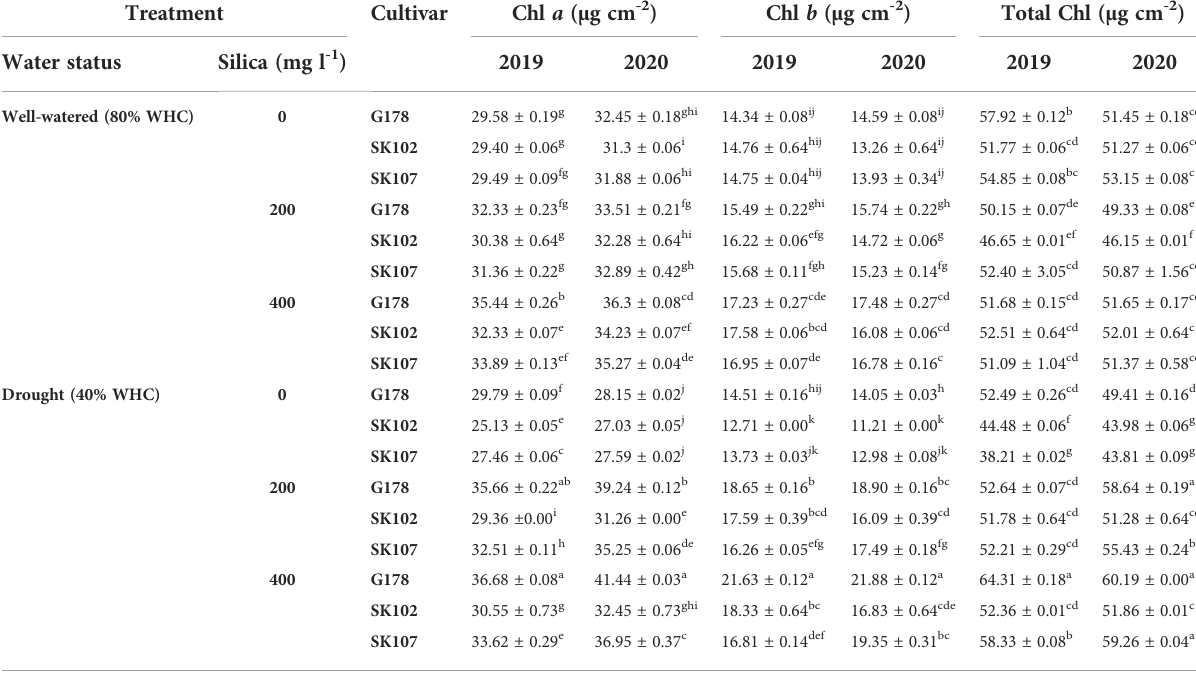
TABLE 5 Effects of foliar application of silica on photosynthetic pigments in response to drought stress during the growing seasons of 2019 and